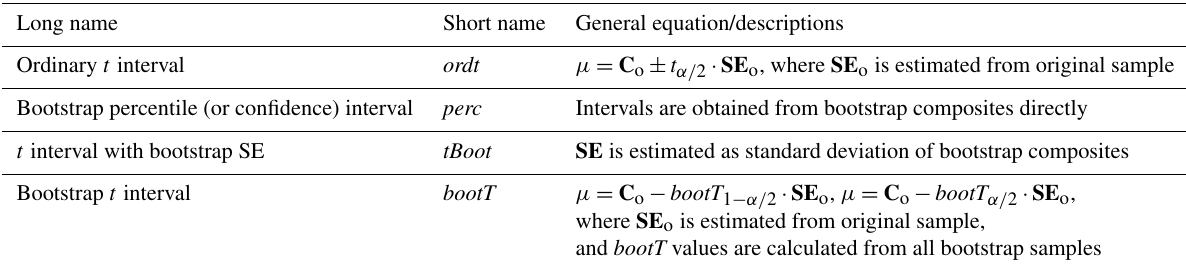
Figure 7. Lower and upper limits of confidence intervals (at 95% level) for the JF El Niño SLP composite corresponding to Fig. 5c. The ordt , perc , and bootT intervals are described in Sect. 3.3. The contour interval is 1hPa, with red (blue) contours indicating positive (negative) anomalies. Gray shading indicates locations where the SLP anomalies have the same sign within the entire interval. Table 3. Types of confidence intervals described Sect. 3.3 and Hesterberg (2015). The subscript α/ 2 indicates a two-tailed t value at α significance level. For example, the current studies uses α = 0 .